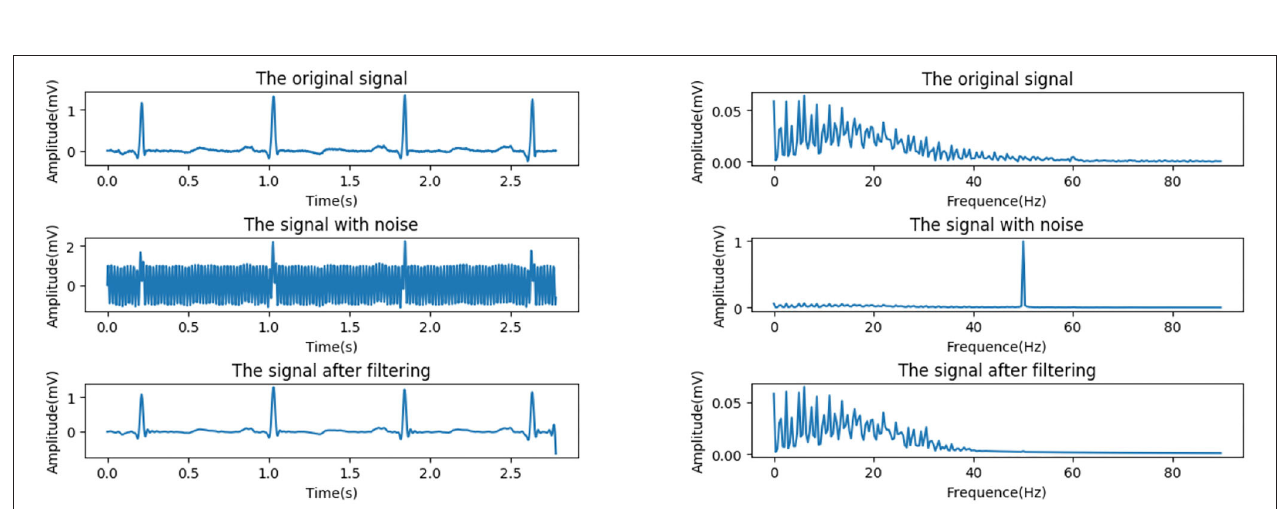
FIGURE 2 | Power frequency interference reduction. (Left) Time domain. (Right) Frequency